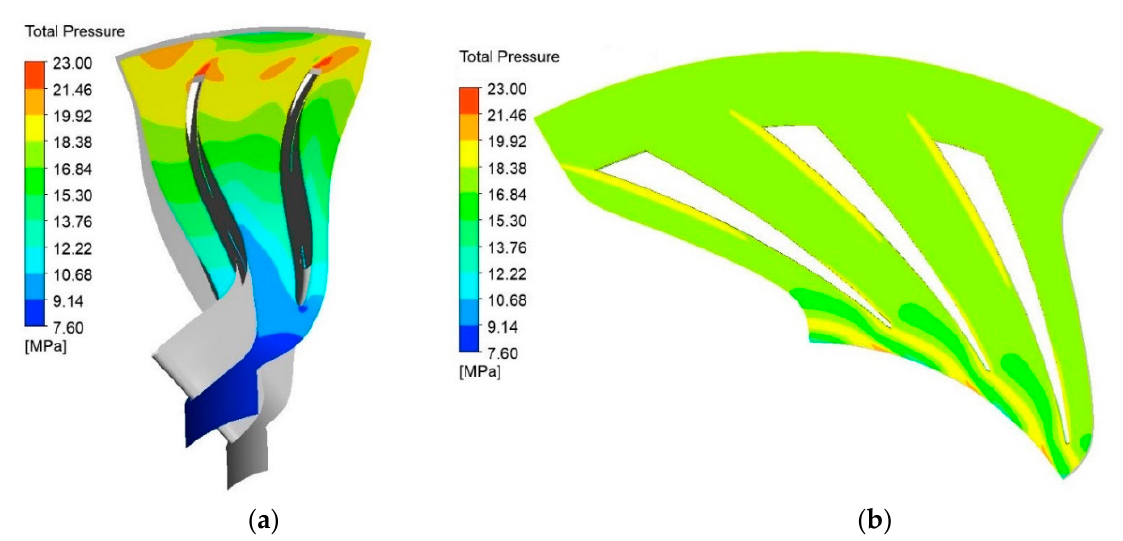
Figure 7. Total pressure: ( a ) lateral view at impeller mid-span; ( b ) blade-to-blade view at diffuser mid-span.